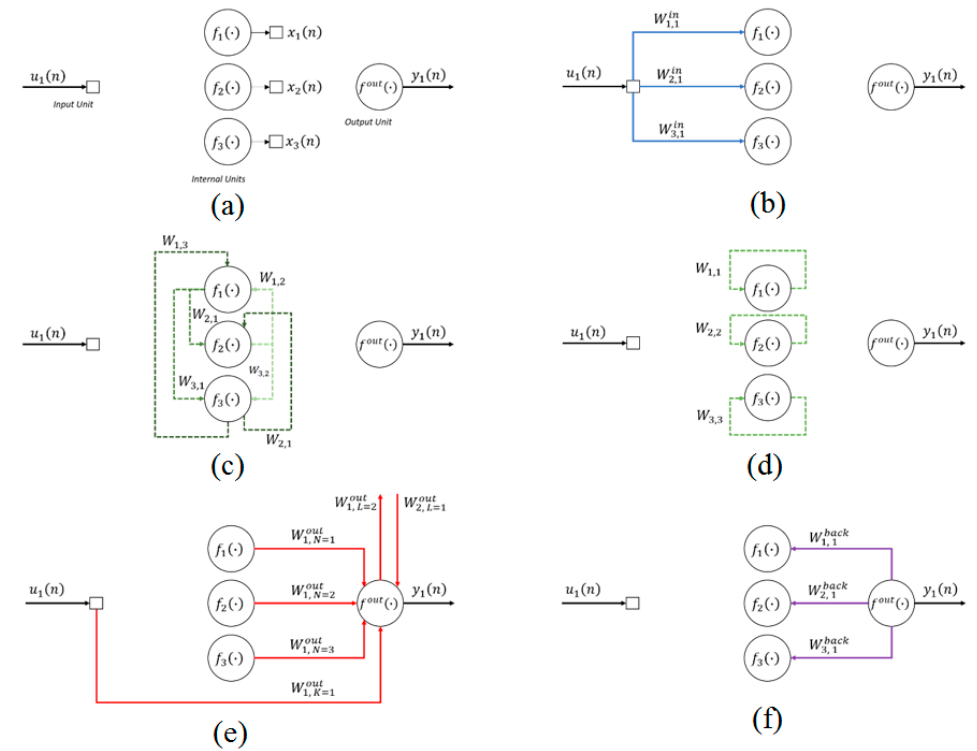
Figure 1. Architecture of an ESN composed of one input unit, three internal units, and one output unit for demonstration purposes: ( a ) description of elementary units; ( b ) internal weights; ( c ) reservoir interconnection weights; ( d ) reservoir intra-connection weights; ( e ) output weights; and ( f ) feedback weights. The sub-index notations mean the unit number, for example: u 1 the input unit number one, f 3 the internal unit number three, x 2 the state of internal unit number two, and y 1 the output unit number one.